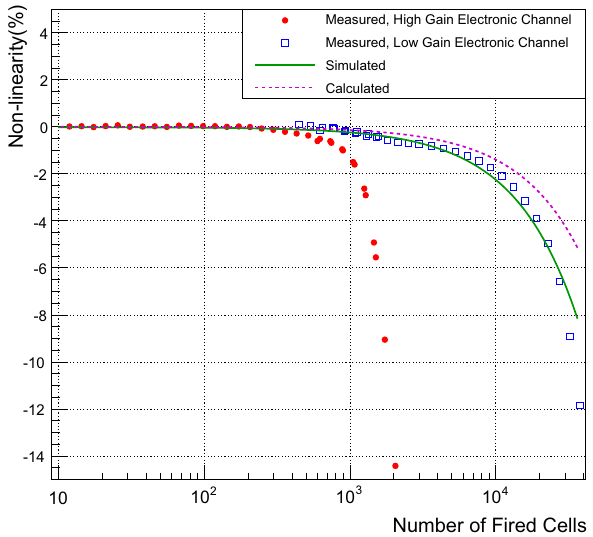
Fig. 13 Overall non-linearities of 16,384 pixels of the first 16 WFCTA cameras. The red circles and the blue hollow squares are the average non-linearities measured by the high gain and the low gain electronic channel of the pixels, respectively. The green line is the non-linearity under the non-uniform illumination which is simulated based on the physical parameters of the light funnel. The purple dashed line repre- sents the non-linearity under the uniform illumination which is calcu- lated from Eq.